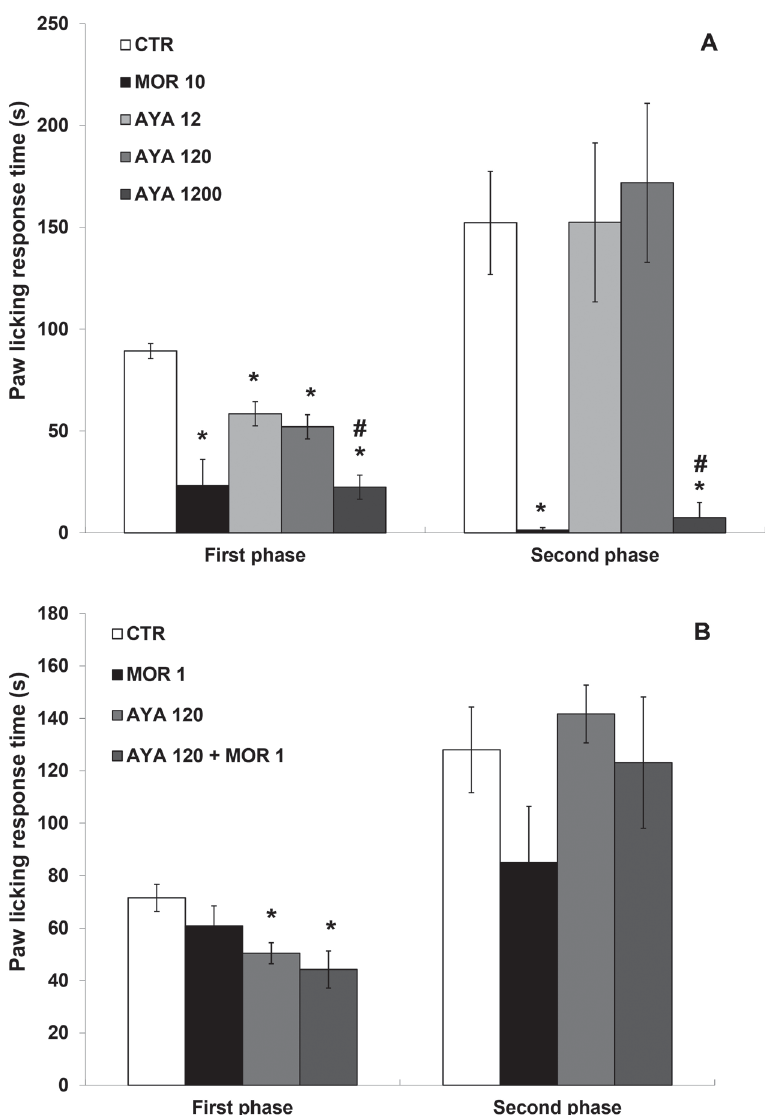
FIGURE 5 - Effect of ayahuasca and morphine on the time that mice spent licking the paw after formalin 2.5% subplantar injection. A) Ayahuasca (AYA, 12, 120 and 1200 mg/kg, p.o.) and morphine (MOR, 10 mg/kg, i.p.) B) Ayahuasca (AYA, 120 mg/kg, p.o.), morphine (MOR, 1 mg/kg, i.p.) and the respective groups of association. Results are expressed as the mean ± SEM (A: n=5-7; B: n=9-10). (*) p <0.05: statistically different from control; (#) p <0.05: statistically different from AYA 12 and AYA 120. ANOVA followed by Duncan’s